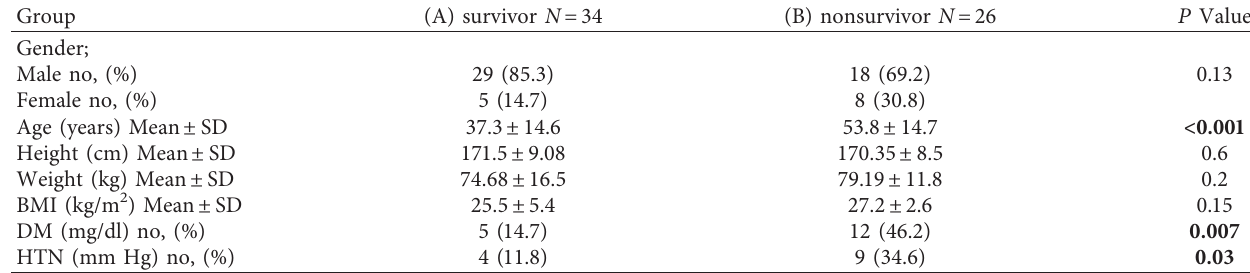
Table 1: Comparative demographic and clinical data in the two study groups.